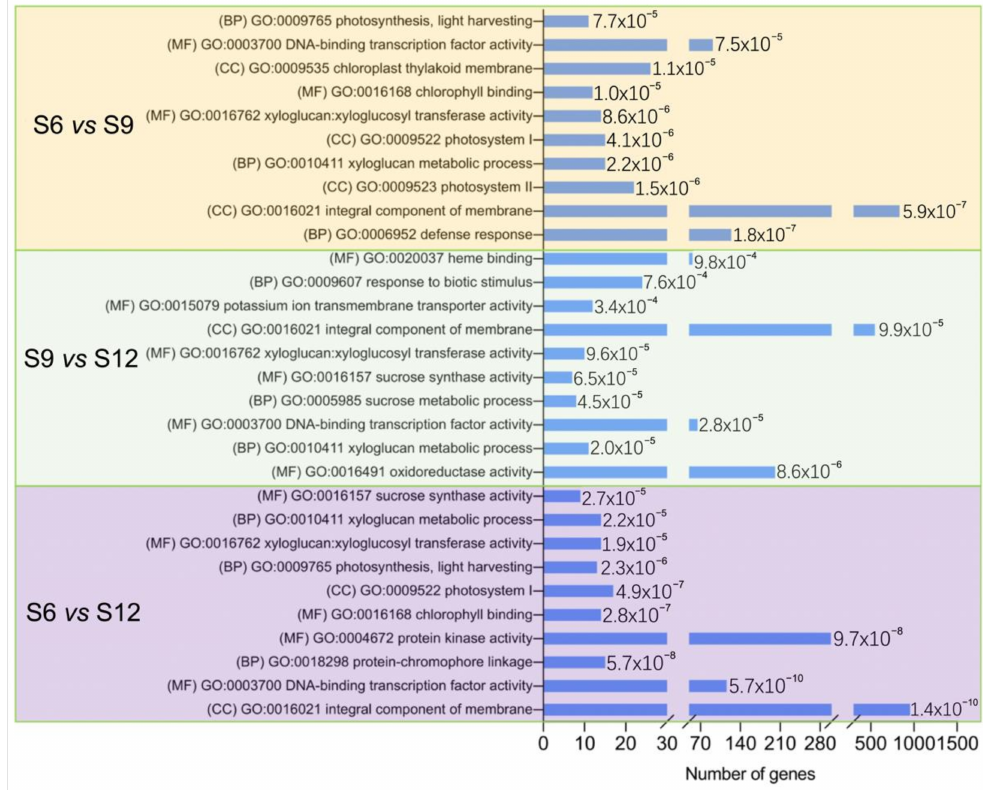
Figure 4. GO enrichment analysis of DEGs between groups was compared. The figure shows the top 10 rich items with extremely significant ( ≤ 0.05) p -values for each comparison, and the values of the p -values are shown in the bar chart. (BP): biological process; (MF): molecular function; (CC): cellular